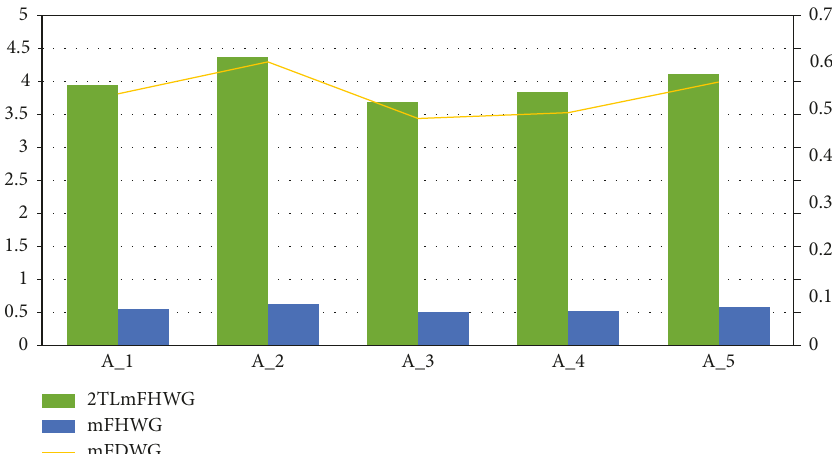
Figure 7: Comparison of proposed operator 2TLmFHWG with existing